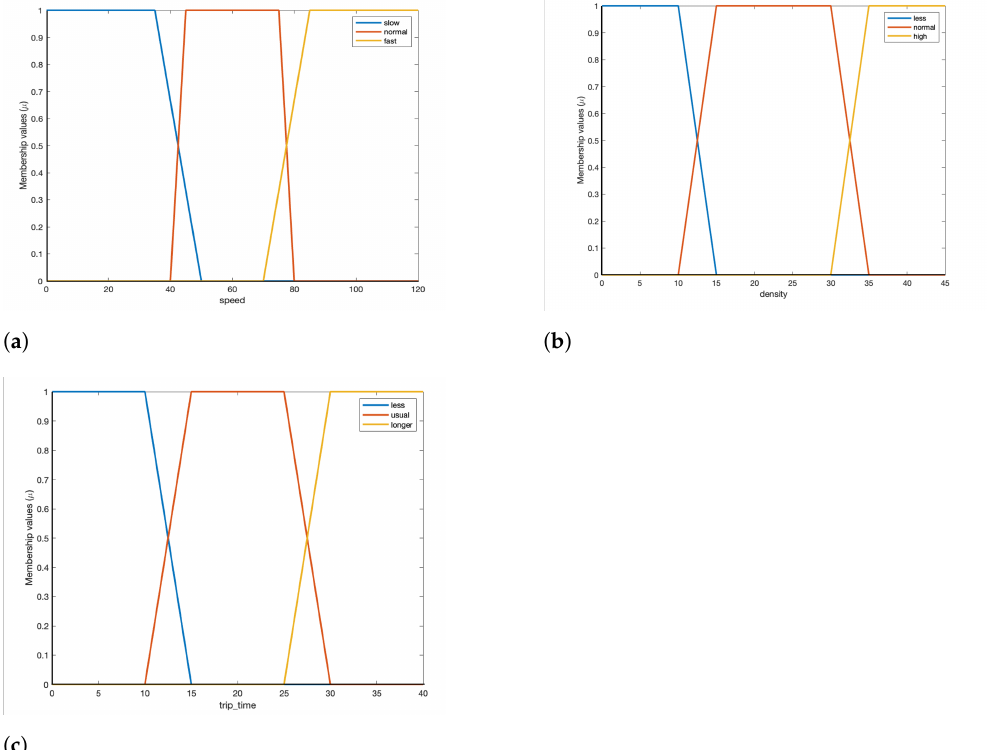
Figure 6. Fuzzy subsets for the input variables of a traffic monitoring application. ( a ) α . ( b ) β . ( c ) γ